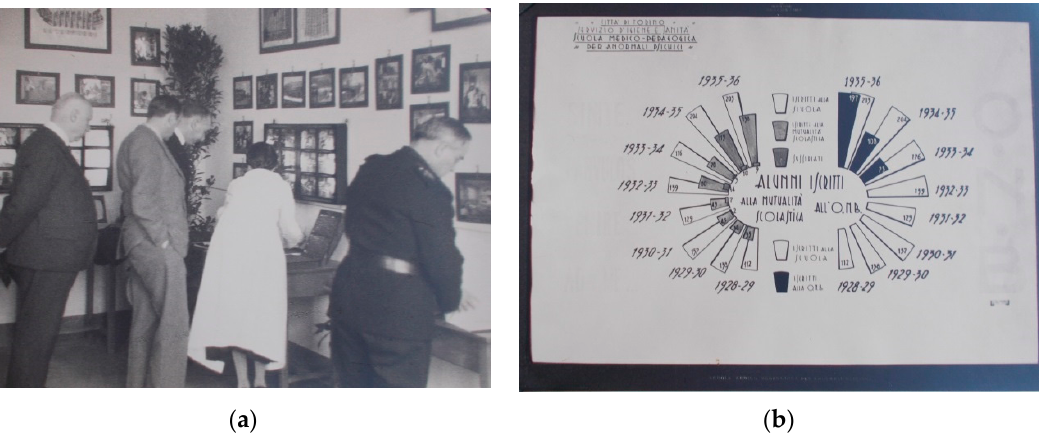
Figure 2. ( a ) Opening of the new school’s center: Manager’s office (ASPG, file 3488); ( b ) Panel representing number of students of the physician-pedagogic school of the Balilla national activity (ASPG, file